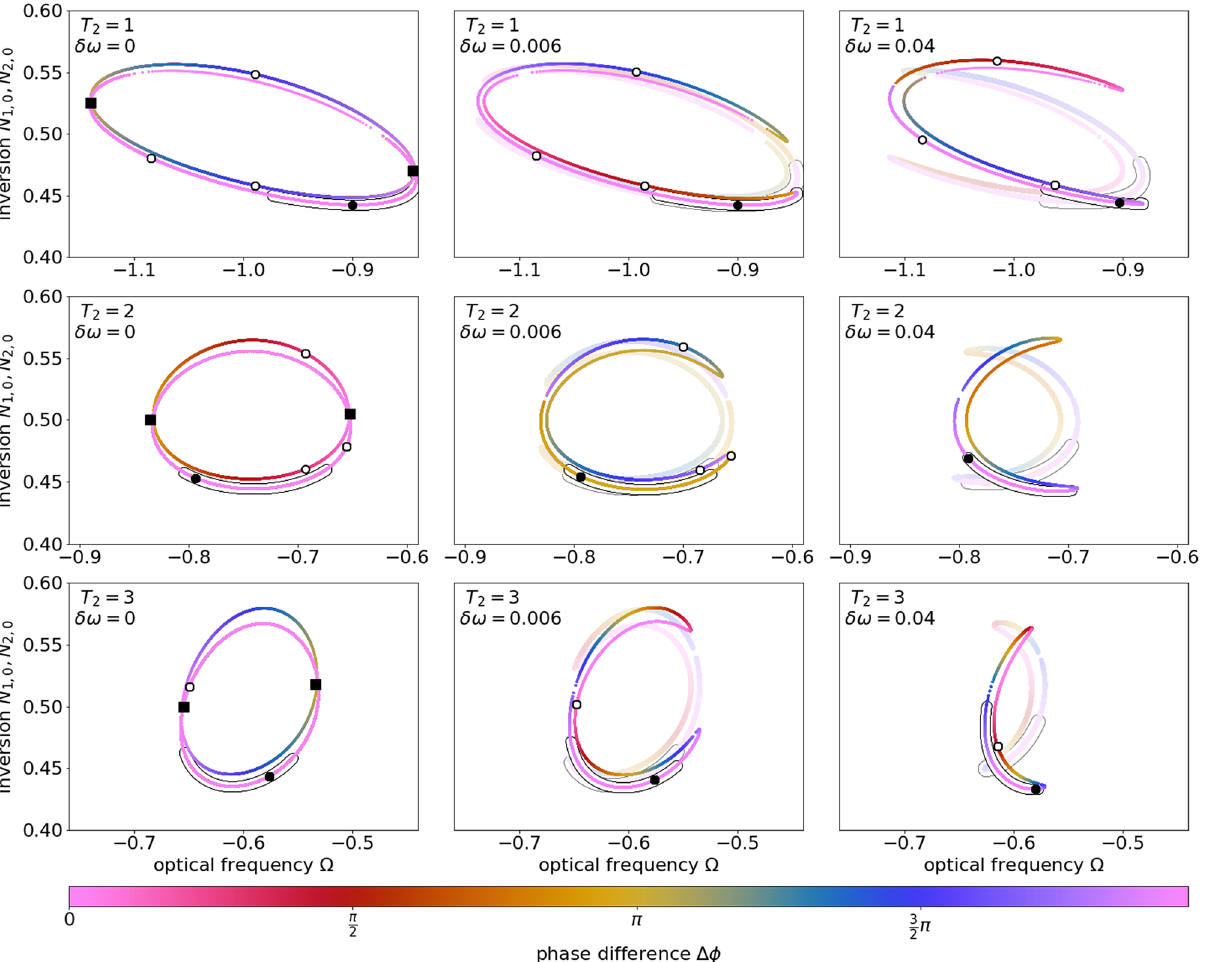
Figure 4. Compound laser modes (CLMs) depicted in (� , N ) -space for θ ∈ [0, 2 π) . From top to bottom the polarization lifetime T 2 increases. From left to right the detuning δω increases. Constant-phase (pink lines) and symmetry-broken CLMs (lines with continuous color) can be distinguished by the color coded phase difference �φ . Pitchfork bifurcations are marked as black squares, solutions for θ = 0 are indicated with white dots (black dots if stable). Stable solutions are indicated by black surroundings. For δω > 0 , the two curves of CLMs connect to one that differs for each laser (transparent for laser 2). Other parameters are �ω = 3 , p = 2 , K = 0.1 , τ = 10 , T = 392 In Fig. 3b two additional branches of symmetry-broken CLMs (also named intermediate-phase CLMs in Ref. 33 , asymmetric solutions in Ref. 36 or out-of-phase solutions in Ref. 35 ) can be seen (curves that change their color) next to the constant phase CLMs. The symmetry broken CLMs are characterized by a phase difference �φ(θ) that varies with the coupling phase, and by non-equal amplitudes E j ,0 33,36,38,44 . As a result the solutions for the two lasers that operate on a symmetry-broken CLM, do not parametrize the same curves in (� , N ) -space. As can be seen in Fig. 3b, the symmetry-broken CLMs emerge in pitchfork bifurcations (black squares) from either in- or anti phase CLMs and vanish in the other. In analogy to the external cavity modes of lasers subject to feedback (steady state solutions of the inten- sity) 12,30 , Fig. 4 shows the CLMs in a (� , N ) -phase projection. Here a matrix of such projection-maps is shown, where the polarization lifetime increases from top to bottom (mimicking the transition from nano- to mesoscale lasers) and the detuning increases from left to right (i.e a change from identical to slightly different lasers). The in- and anti-phase CLMs can be found in pink and yellow in the left column for vanishing detuning. They lie on the same curves due to their identical amplitudes up to phase shifts of π . Stable solutions are indicated by black surroundings. Again the symmetry-broken CLMs (curves that change color in Fig. 4) connect the in- and anti- phase CLMs via pitchfork bifurcations (squares). Within every column of the matrix the polarization lifetime T 2 ∈ { 1, 2, 3 } is varied from top to bottom. This change in T 2 decreases the width of the gain spectrum, which is proportional to 1 T (see Fig. 1b). As a result, the solutions for the coupled laser system are found on a smaller 2 range of CLM frequencies (cid:31) . The consequences of non-vanishing detunings on the CLMs can be seen in the second and third column of Fig. 4. For each row, the polarization lifetime T 2 is constant and the detuning δω is increased. Apart from T 2